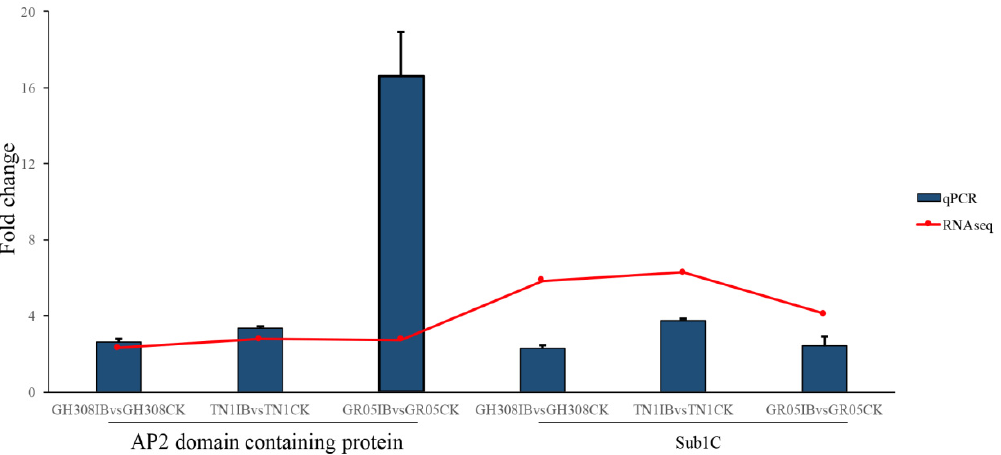
Figure 9. Validation of RNA-seq results using qRT-PCR. An AP2 domain-containing gene and a Sub1C gene were randomly selected for testing. The blue column represents the fold change of the qPCR quantification of each gene between BPH-treated and control samples, and the red dot represents the fold change of the RNA-seq quantification in the same